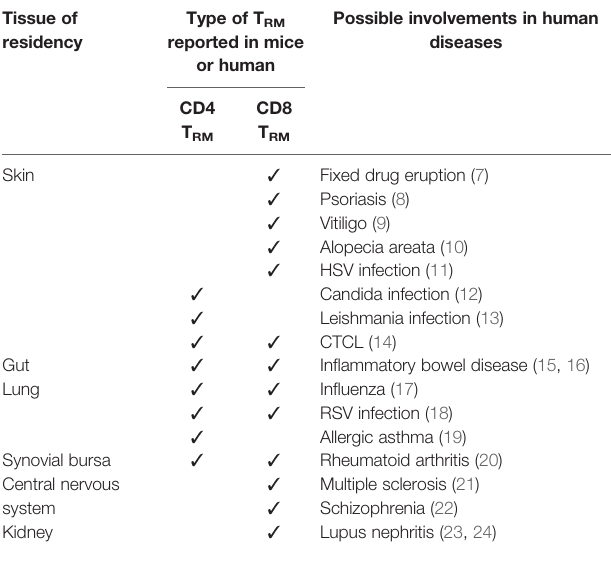
TABLE 1 | Resident memory T cells in various tissues in mice and